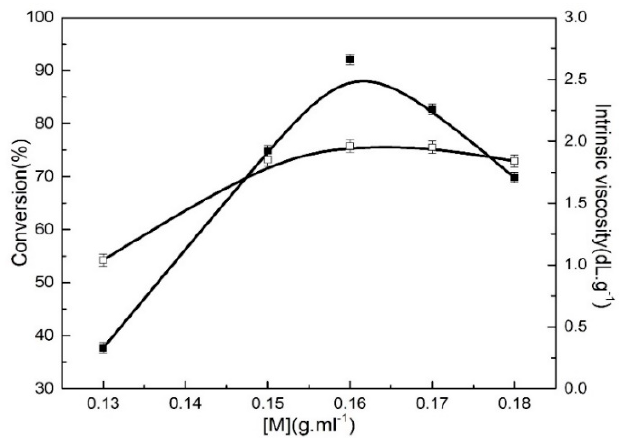
Figure 6. Effect of monomer concentration of 0.13–0.18 g · mL − 1 on the monomer conversion and intrinsic viscosity at a Bd:Ip mole ratio of 9:1. Polymerization conditions: [M] = 0.18 g · ml − 1 , TNPP:Mo = 6, Al:Mo = 5, t = 7 h, Mo:[M] = 8 × 10 − 4 , nBd:nIp = 9:1.